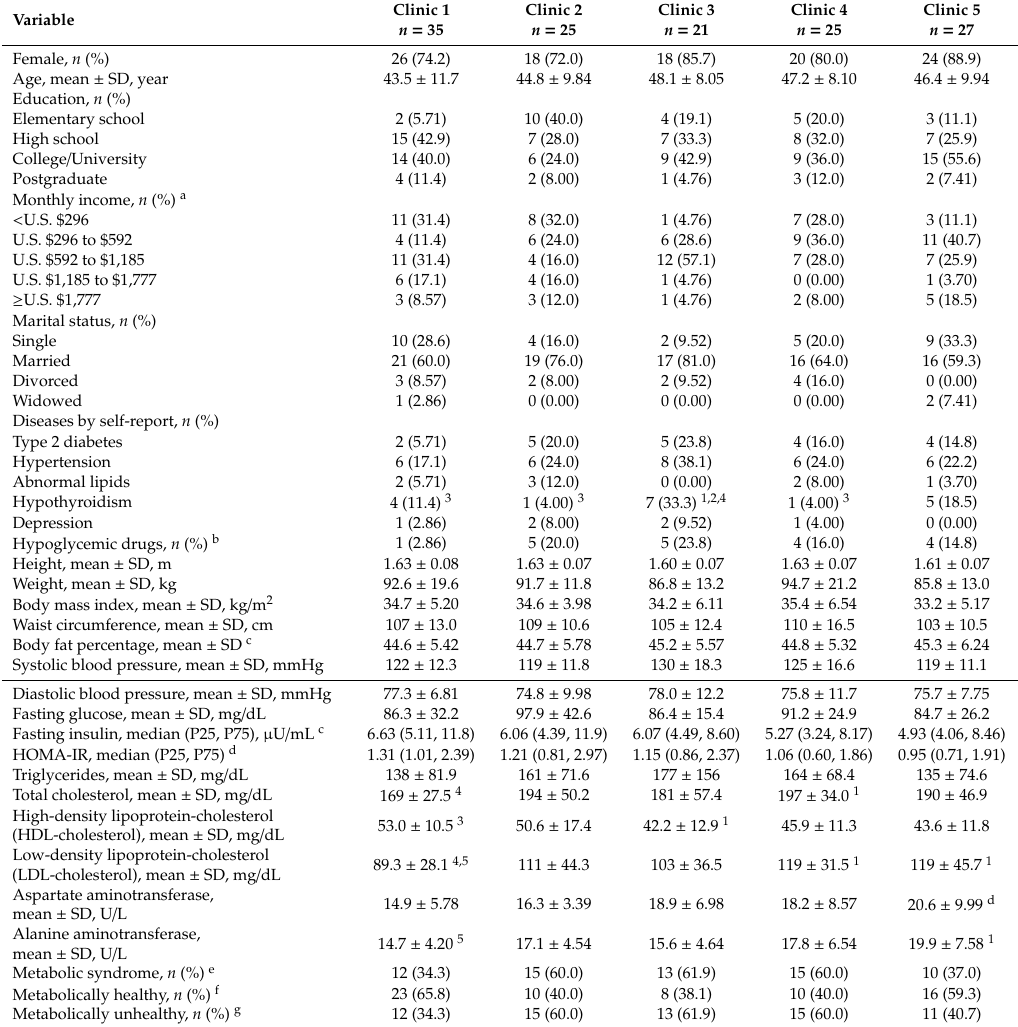
Table 2. Baseline characteristics of participants completing the 6 months of intervention ( n = 133).